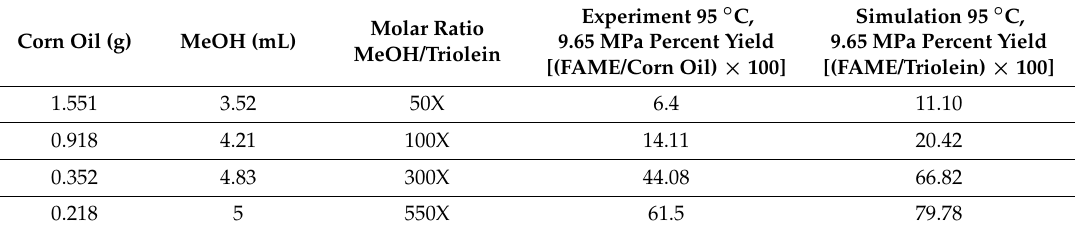
Table 2. Experimental and Simulated Fractional FAME Yield using Methanol/TG Molar Ratios at 95 ◦ C, 9.65